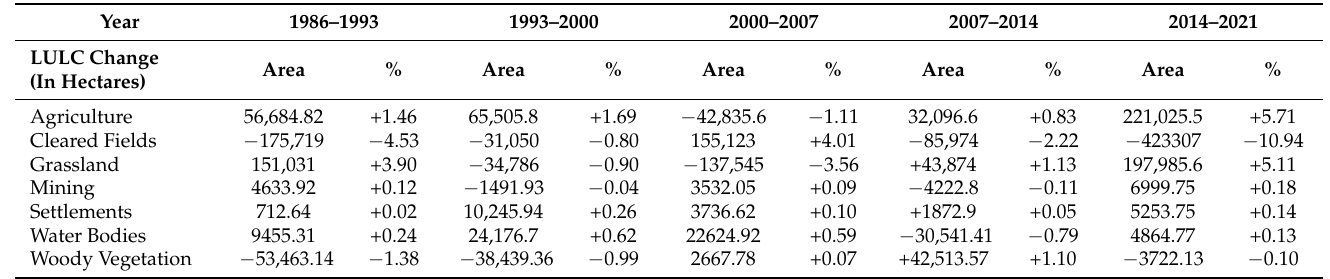
Table 7. Area and percentage changes of the land use land cover (LULC) in the Vaal Dam Catchment for 1986, 1993, 2000, 2007, 2014 and 2021 images.